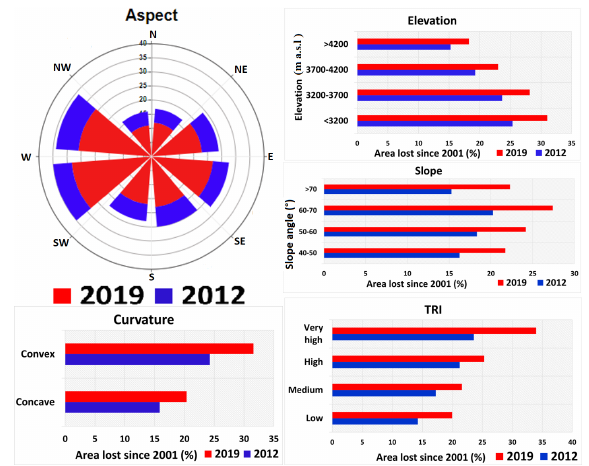
Figure 6. Area loss (%) of Ice Aprons based on different topographic